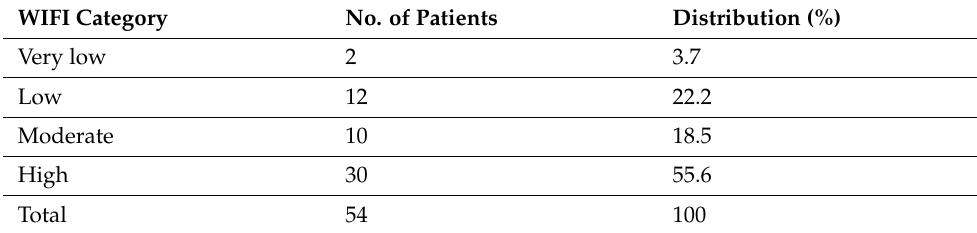
Table 3. WIFI categories in the study population (n = 54).